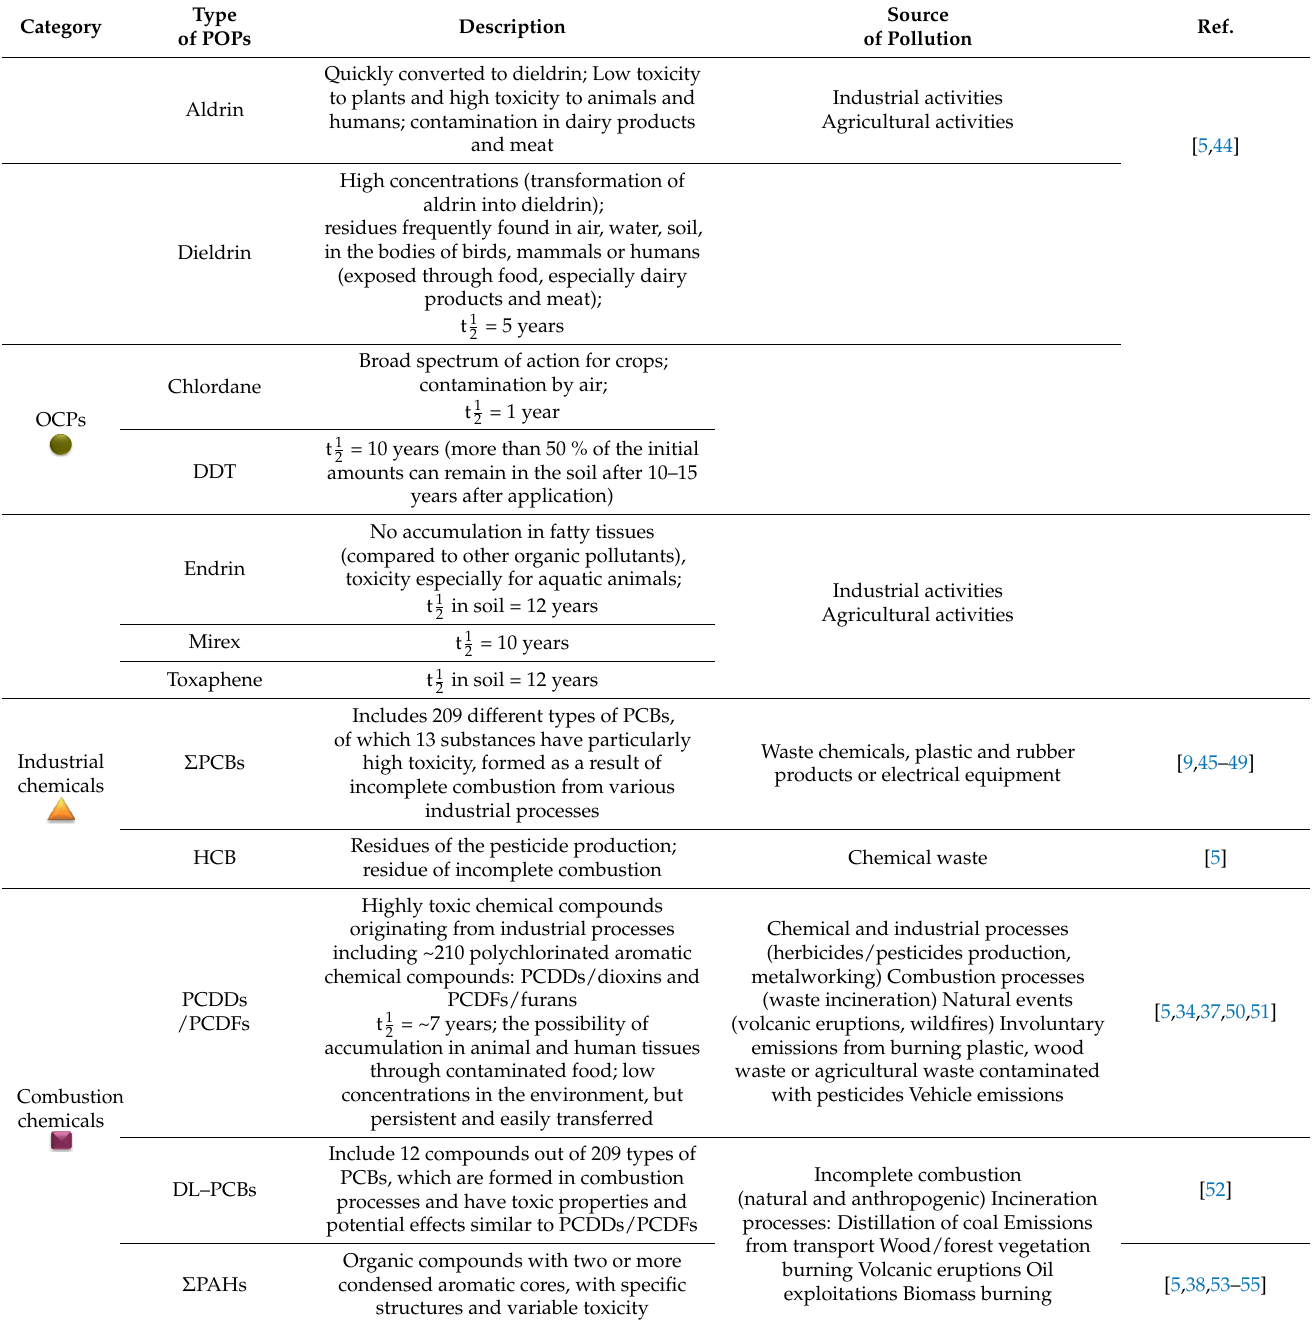
Table 1. Characteristics of POPs listed in the Stockholm